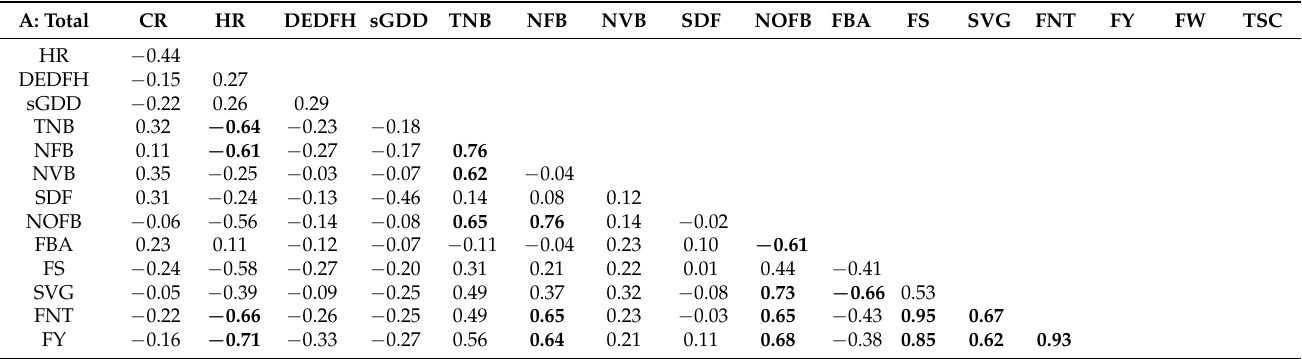
Table 9. Pearson’s correlation coefficients (r) amongst 17 measures for four deficit irrigation treatments (control—Cont., moderate regular deficit irrigation—RDIm, severe regular deficit irrigation—RDIs and continuous deficit irrigation—CDI)